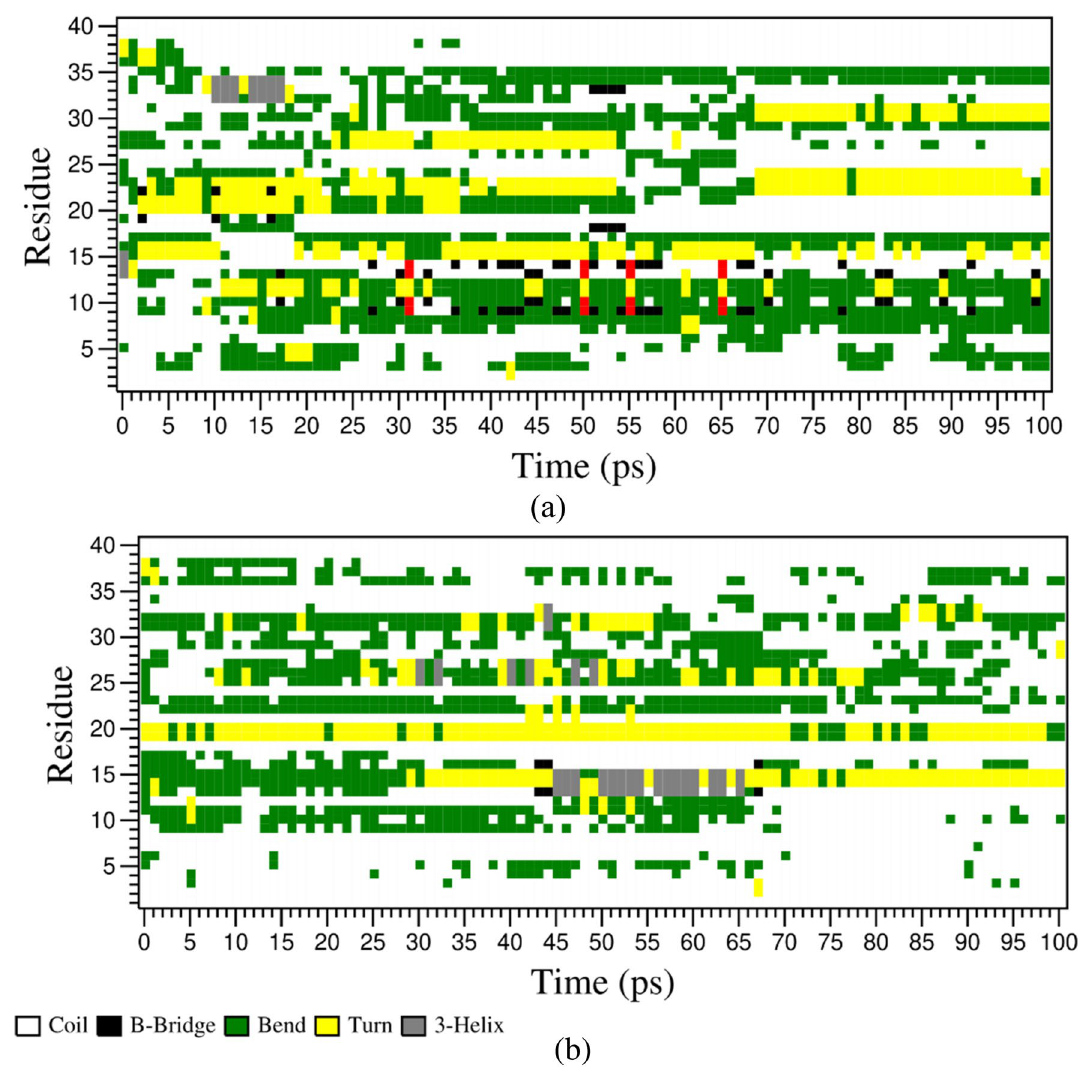
Figure 9. Change in secondary structure elements of SSTR2 N-terminal in the presence ( a ) or absence ( b ) of DPPC bilayer over simulation